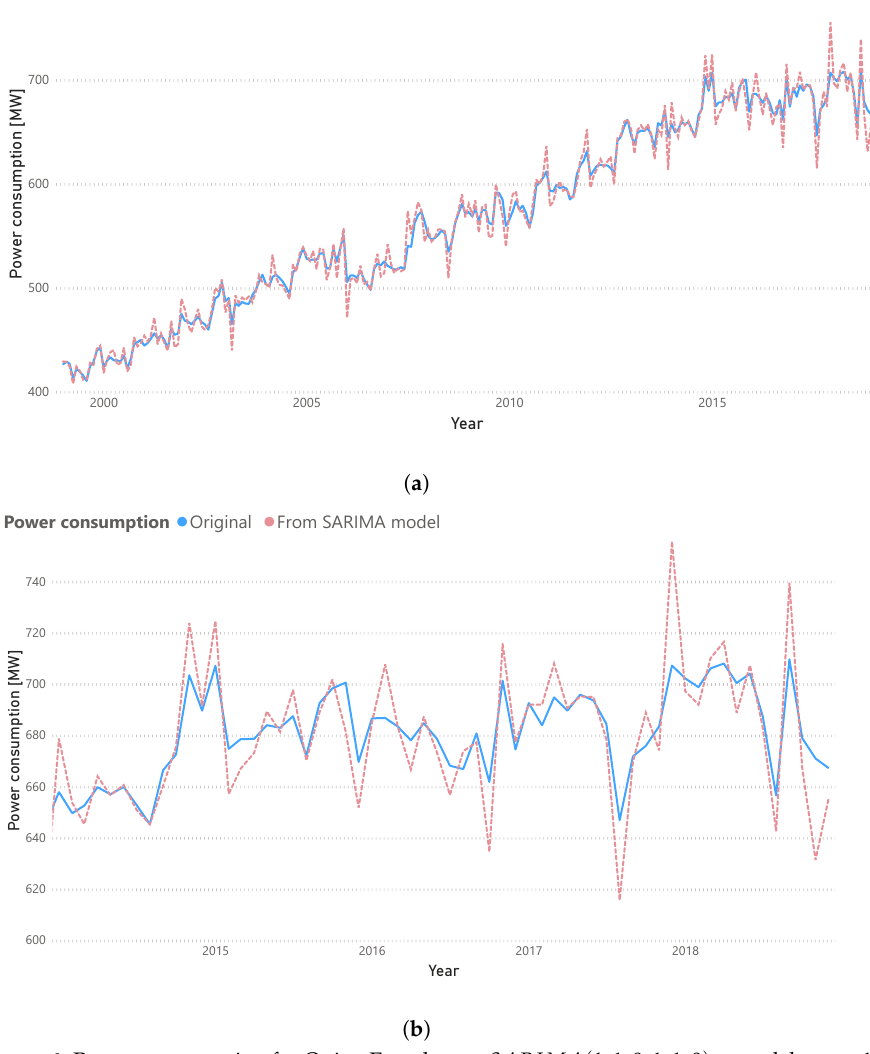
Figure 6. Power consumption for Quito, Ecuador vs. SARIMA ( 1,1,0,1,1,0 ) 12 model, years 1999–2018. ( a ) Power consumption vs. SARIMA modelled data, Period 1999–2018. ( b ) Power consumption vs. SARIMA modelled data, Period